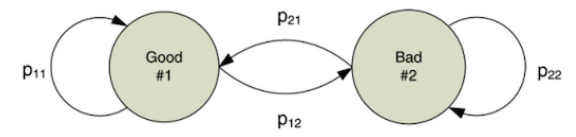
Figure 3. Two-state Markov channel